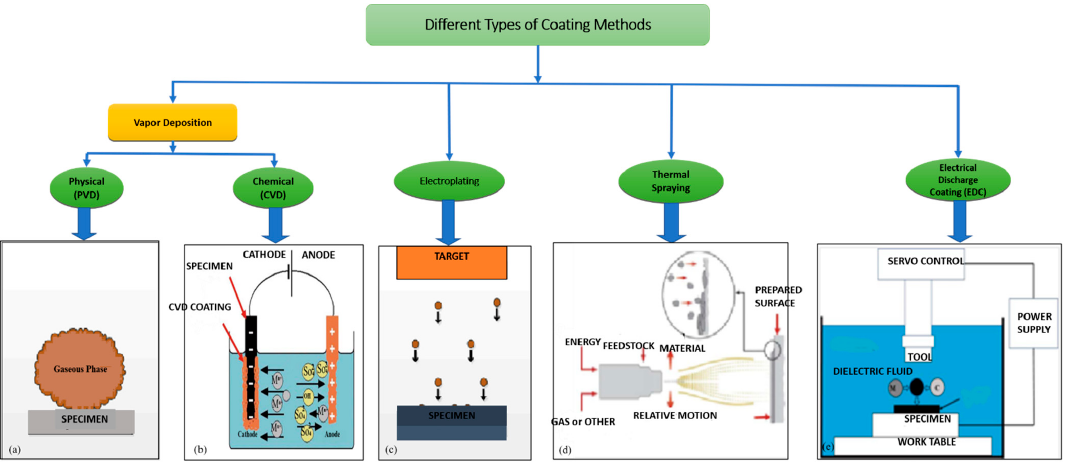
Figure 3. Different coating methods, ( a ) PVD, ( b ) CVD, ( c ) Electroplating, ( d ) Thermal and ( e ) Electrical discharge coating.